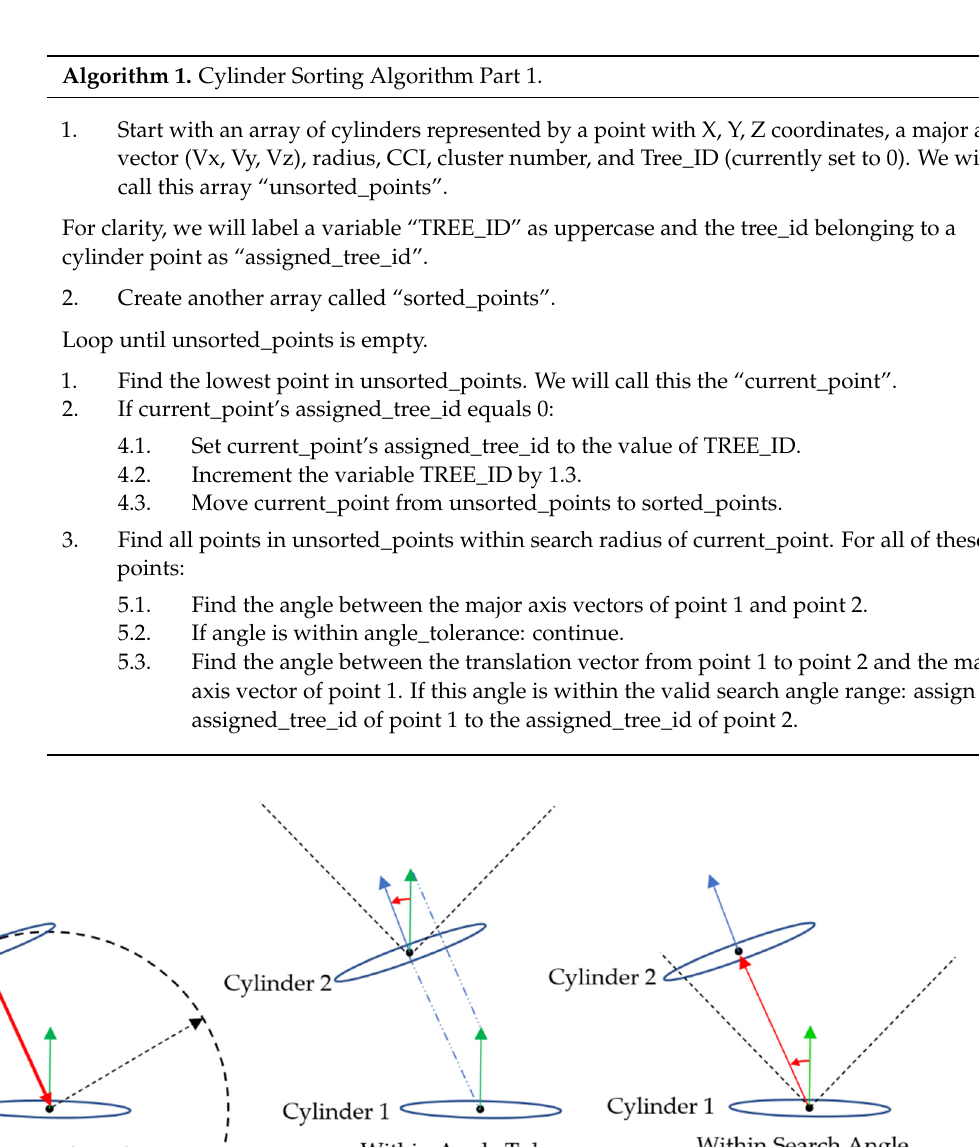
Algorithm 1. Cylinder Sorting Algorithm Part 1.